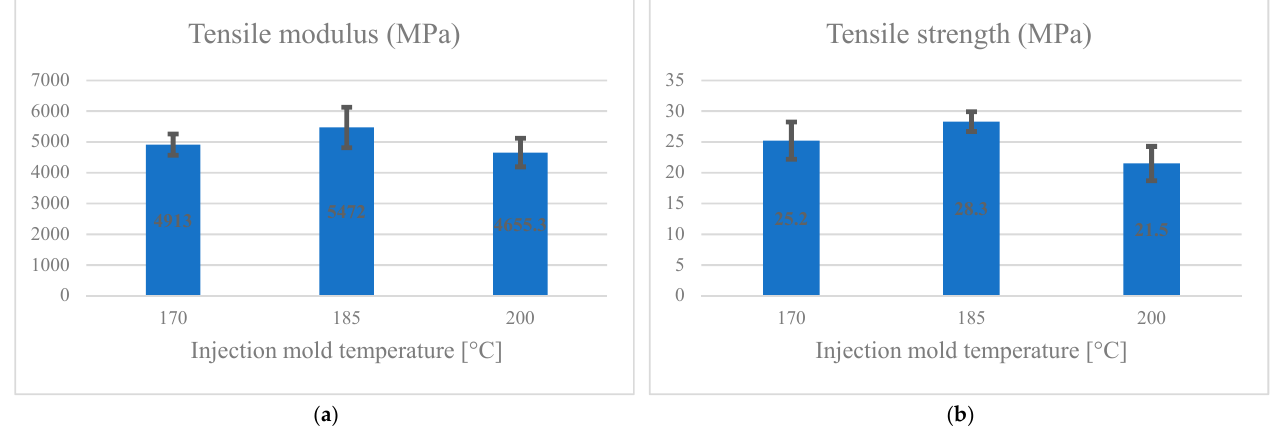
Figure 6. The effect of injection mold temperature on tensile ( a ) modulus; ( b ) strength. Figure 7a,b presents the effect of injection mold temperature on the flexural modulus and strength, respectively. The maximum flexural modulus corresponds to the specimens made at the mold temperature of 185 °C (4107.7 MPa). The minimum that belonged to one group corresponding to the samples made at the injection mold temperature of 170 °C (3478.7 MPa). As the injection mold temperature increased, the flexural strength first increased, and then with a further rise in temperature, the strength decreased, which was not statistically significant. The maximum flexural strength was related to the samples made at the injection temperature of 185 °C (48.4 MPa). The minimum strength was related to the pieces made at the pressing temperature of 170 °C (43.9 MPa).